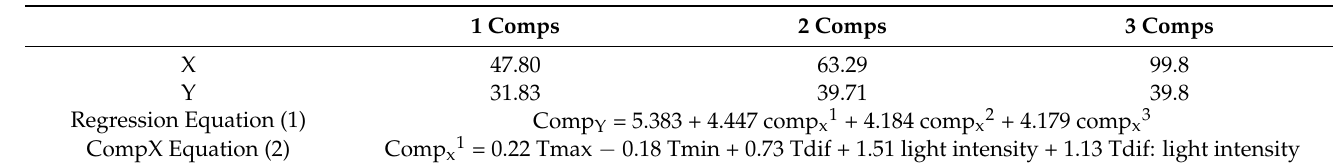
Table 1. PLS regression model of meteorological factors on flavonoid key enzyme gene expression of Tartary buckwheat.